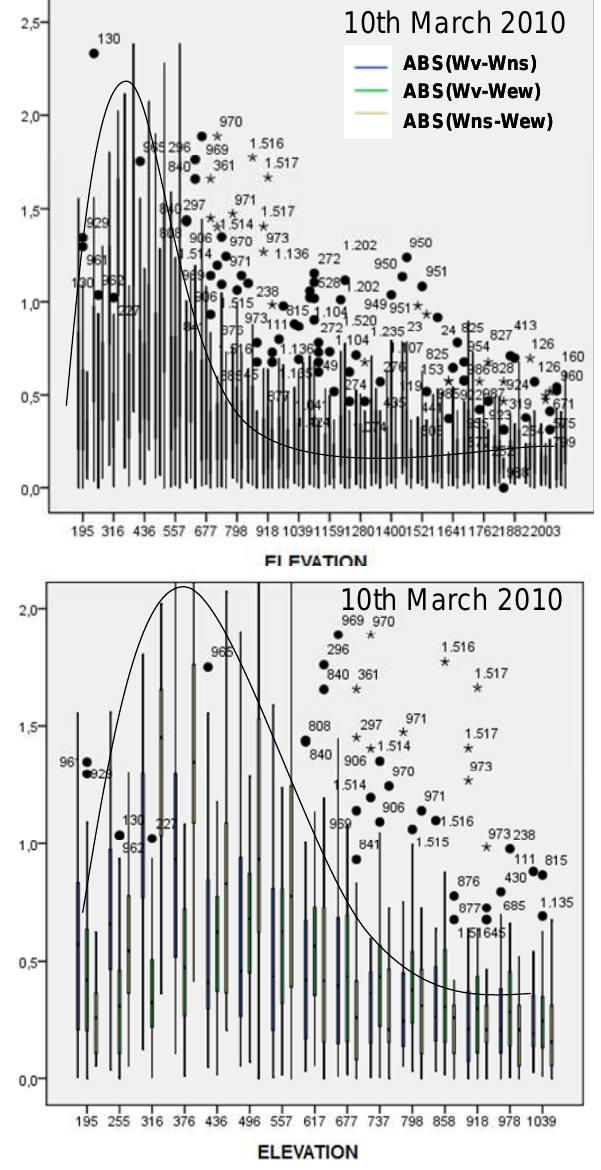
Fig. 8. North pattern: box plots of the vertical velocities on 10 March 2010. x axis (height in ma.s.l.). y axis (velocity in ms − 1 ) . (top) Velocities up to the height of 2000m. Red line represents the limit line between “no homogeneous” and “homogeneous” areas. (bottom) Zoom of the first kilometre. Red line indicates the deviations. Blue line represents the trend.